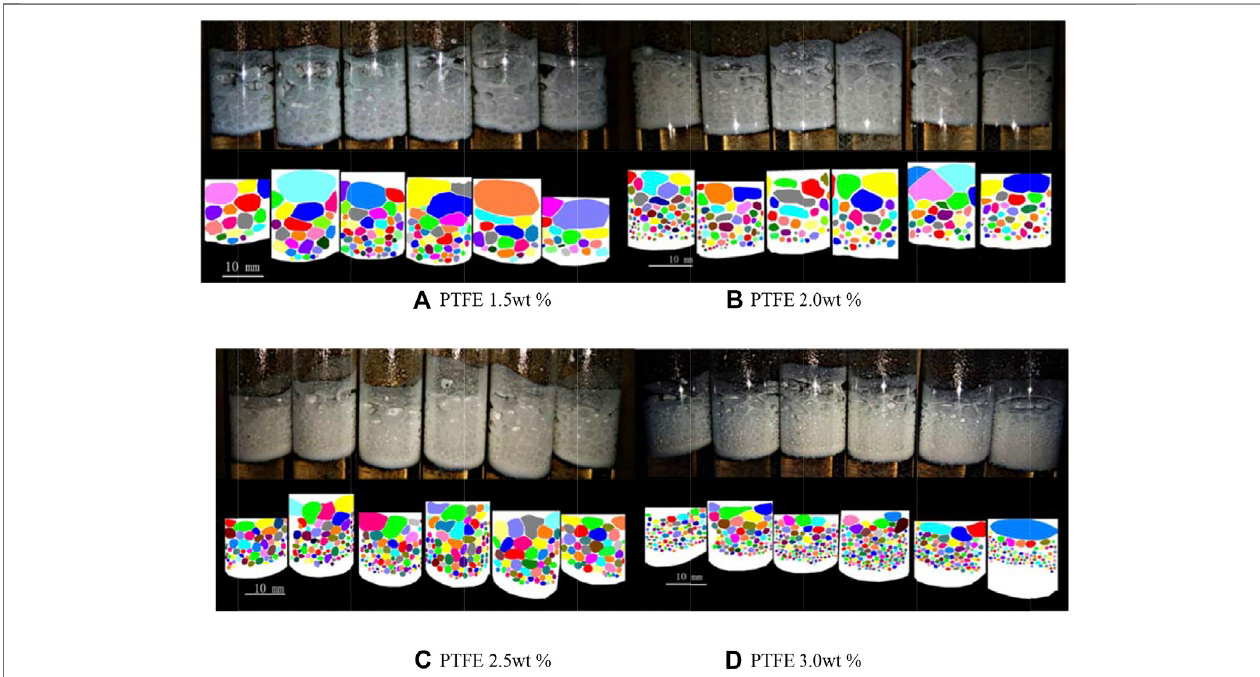
FIGURE 8 | Foam structure with different PVC particle concentration (Each graph from left to right: 0.3 wt%, 0.6wt%, 0.9 wt%, 1.2 wt%, 1.5 wt%, and 1.8 wt% PVC). (A) PTFE 1.5 wt% (B) PTFE 2.0 wt% (C) PTFE 2.5 wt% (D) PTFE 3.0 wt%.